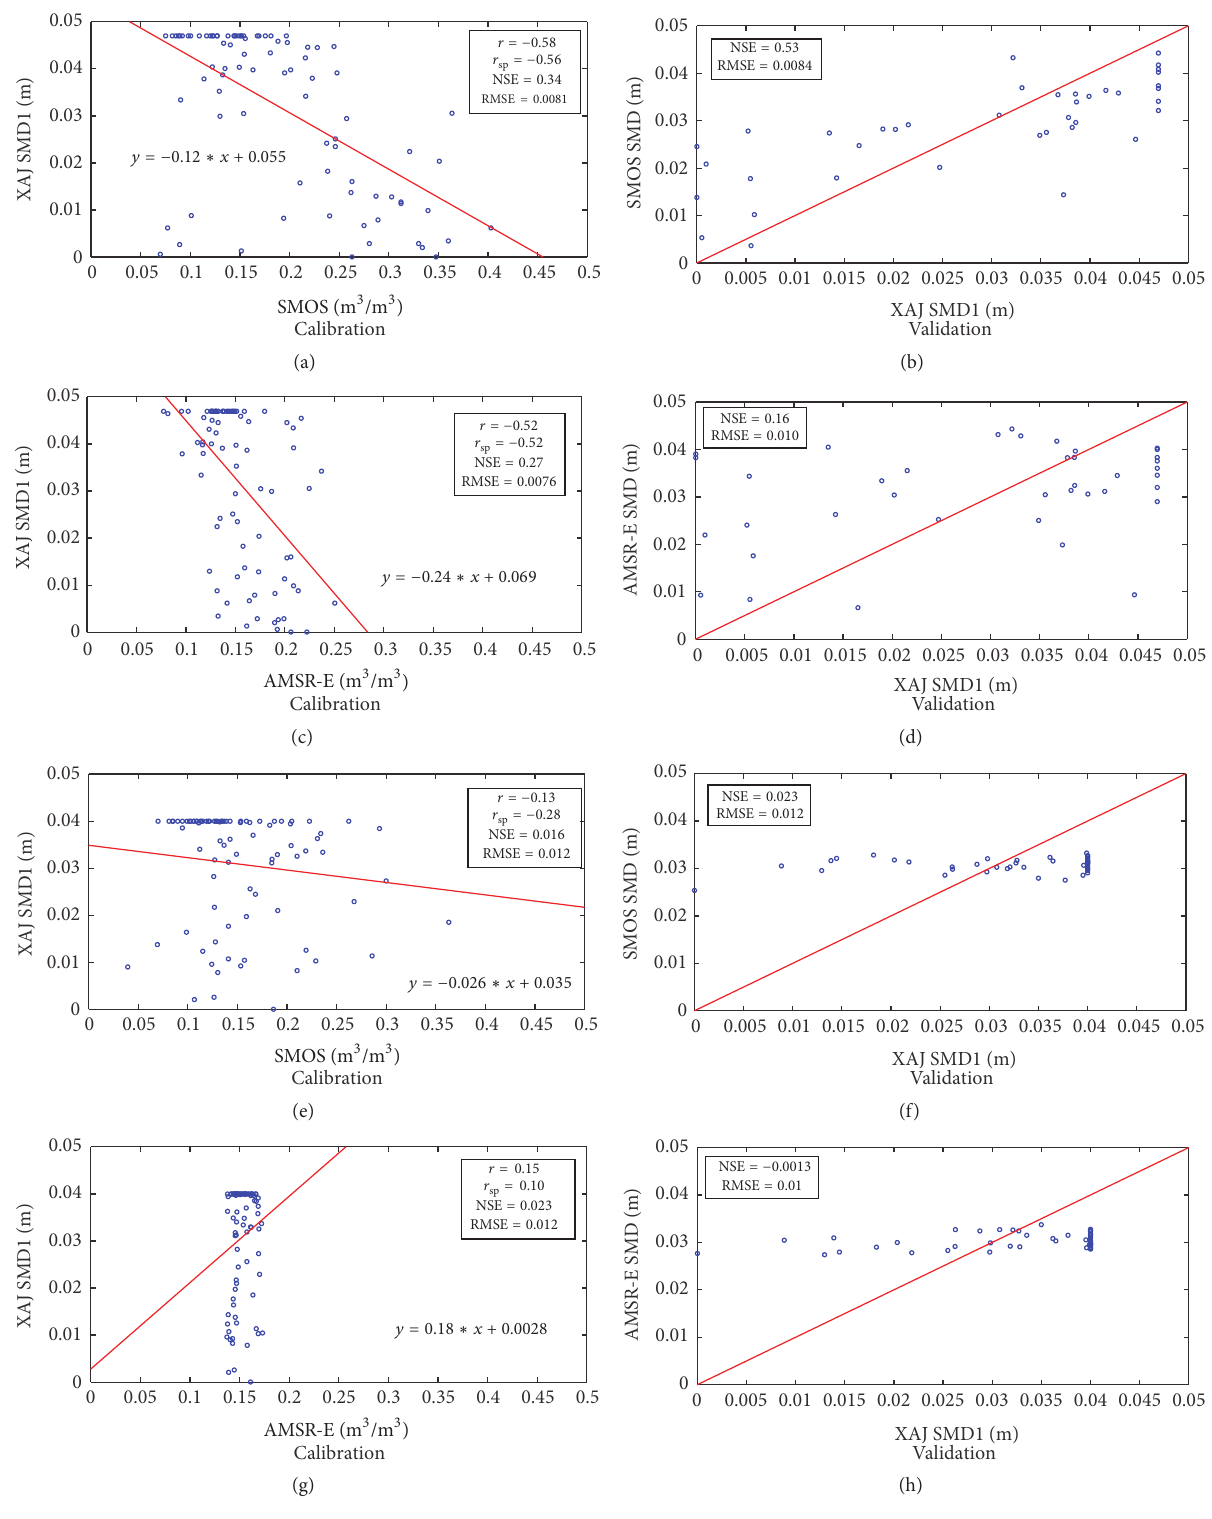
Figure 6: The calibration and validation results using the whole year data. For PB the calibration scatter plots between XAJ SMD1 and SMOS (a) and AMSR-E (c) are presented, and the validation between SMOS derived SMD and original XAJ SMD1 (b) and between AMSR-E derived SMD and original XAJ SMD1 (d) are shown. For FBB the calibration scatter plots between XAJ SMD1 and SMOS (e) and AMSR-E (g) are illustrated, and the validation between SMOS derived SMD and original XAJ SMD1 (f) and between AMSR-E derived SMD and original XAJ SMD1 (h) are shown. It is important to note that, for the calibration, the calculated NSE and RMSE are between the XAJ SMD1 and the satellites’ derived SMD during the calibration period; therefore all the RMSEs shown here are in the unit of